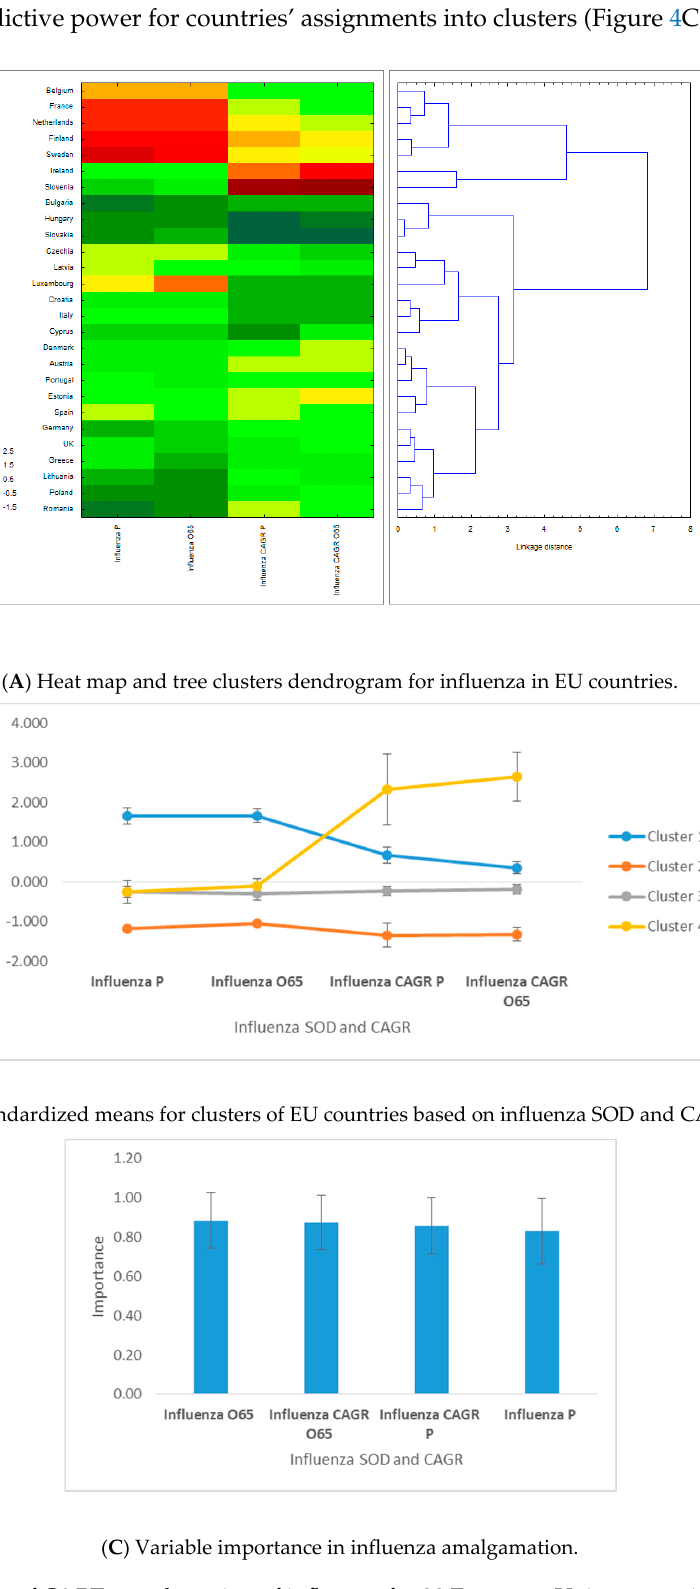
Figure 4. Results of C&RT tree clustering of influenza for 28 European Union countries: heat maps, cluster attributes, and variable importance. (1) Tree clustering results are based on Euclidian distances and the Ward’s amalgamation method applied on shares of death (SOD) and compound annual